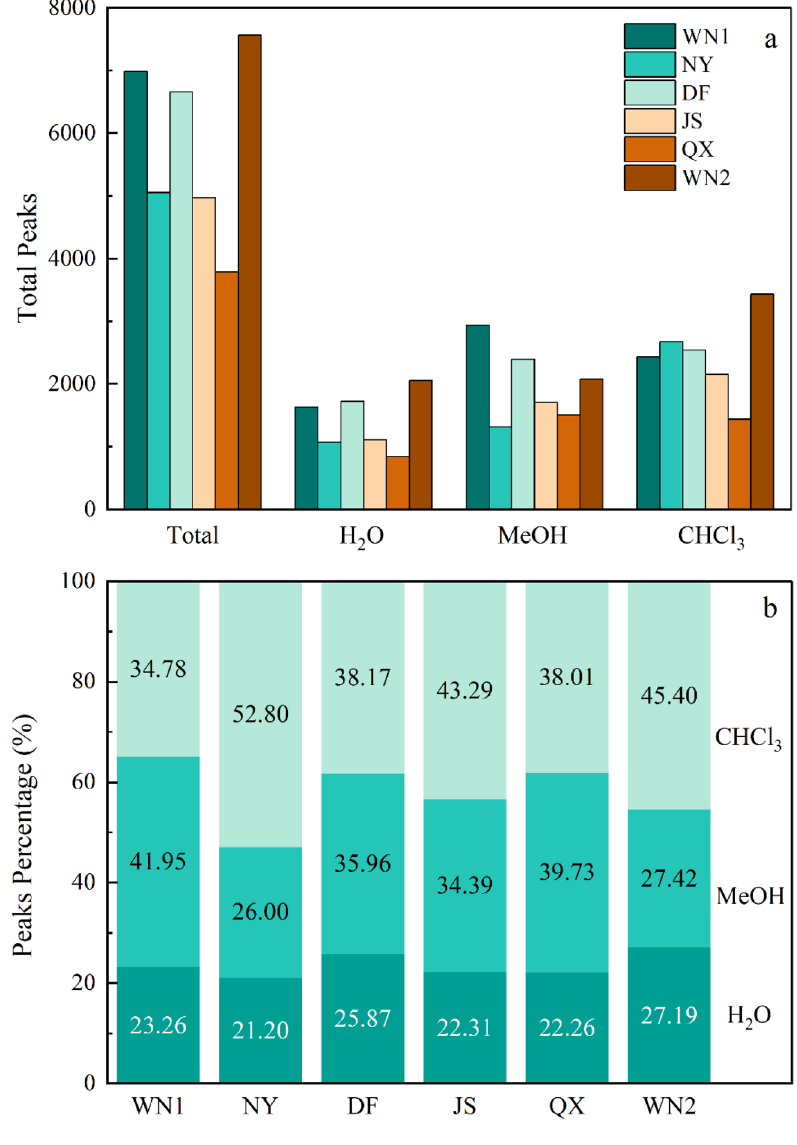
Figure 3. Peak patterns of SOM compounds in soil samples extracted sequentially by H 2 O, MeOH, and CHCl 3 . ( a ) The number of total peaks in soil samples collected in six sites. ( b ) The percentage of peaks extracted by H 2 O, MeOH, and CHCl 3